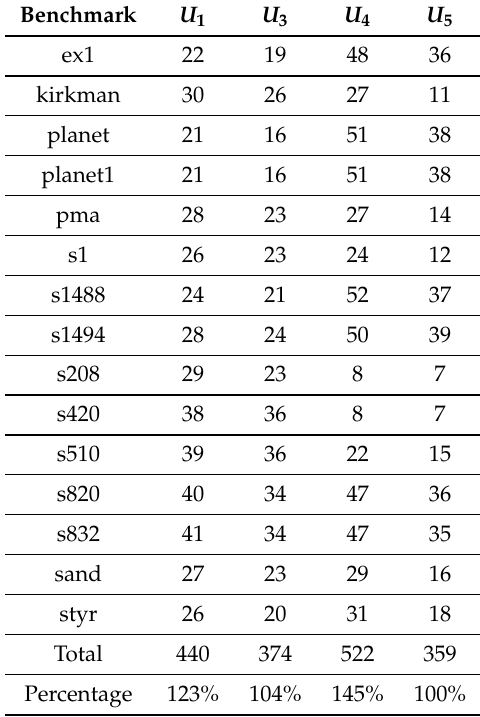
Table 8. Results of experiments (the number of LUTs).